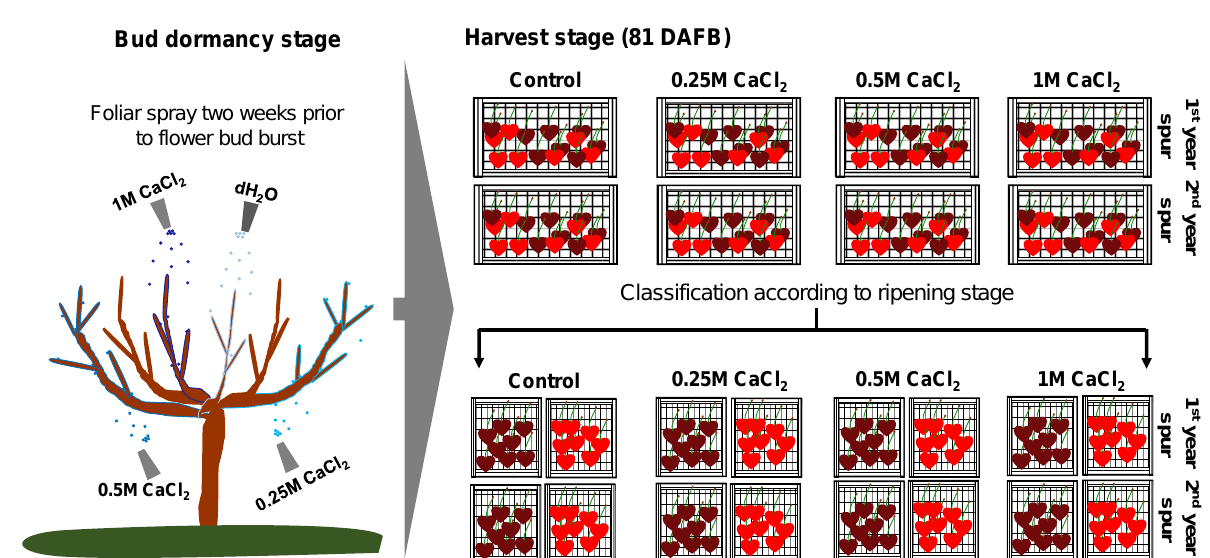
Figure 1. Schematic representation of the experiment procedure. Calcium treatments (0, 0.25, 0.5, and 1M CaCl 2 *2H 2 O) were applied in sweet cherry (cv. Ferrovia) trees at bud dormancy stage, specifically two weeks prior to flower bud burst. Sweet cherry fruits were harvested and grouped based on calcium treatments, the ages of short spurs (1- and 2-year-old spurs) and the ripening stage (red and black colour); afterwards, samples were analysed for nutrient content, quality attributes, and skin metabolites.